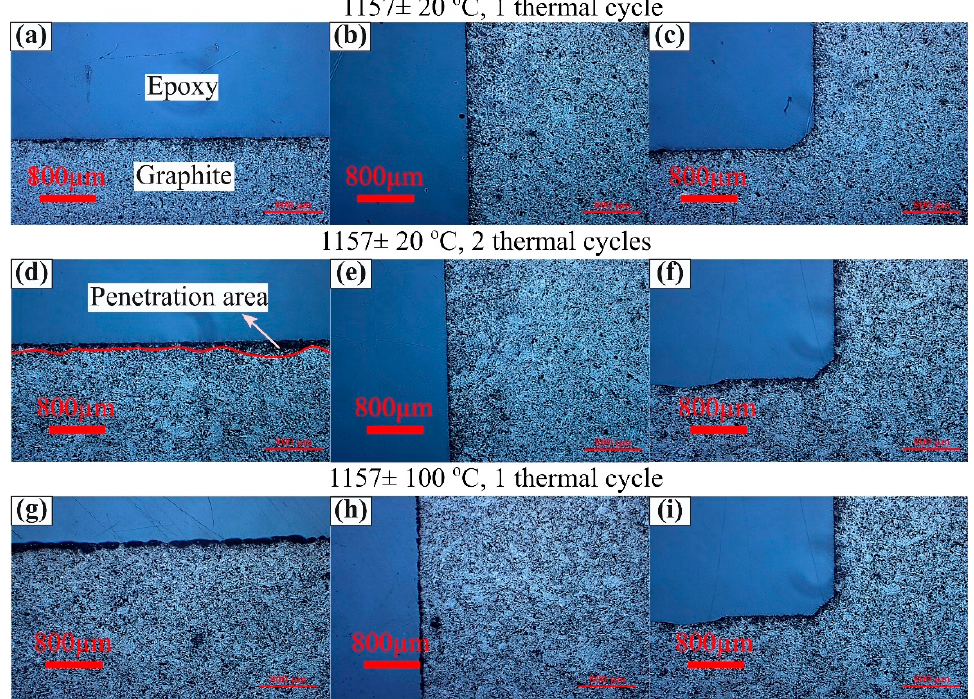
Figure 15. Images of the contact area of the alloy and the graphite crucible at ( a , d , g ) bottom of the crucible, ( b , e , h ) left wall of the crucible, and ( e , f , i ) left corner of the crucible.